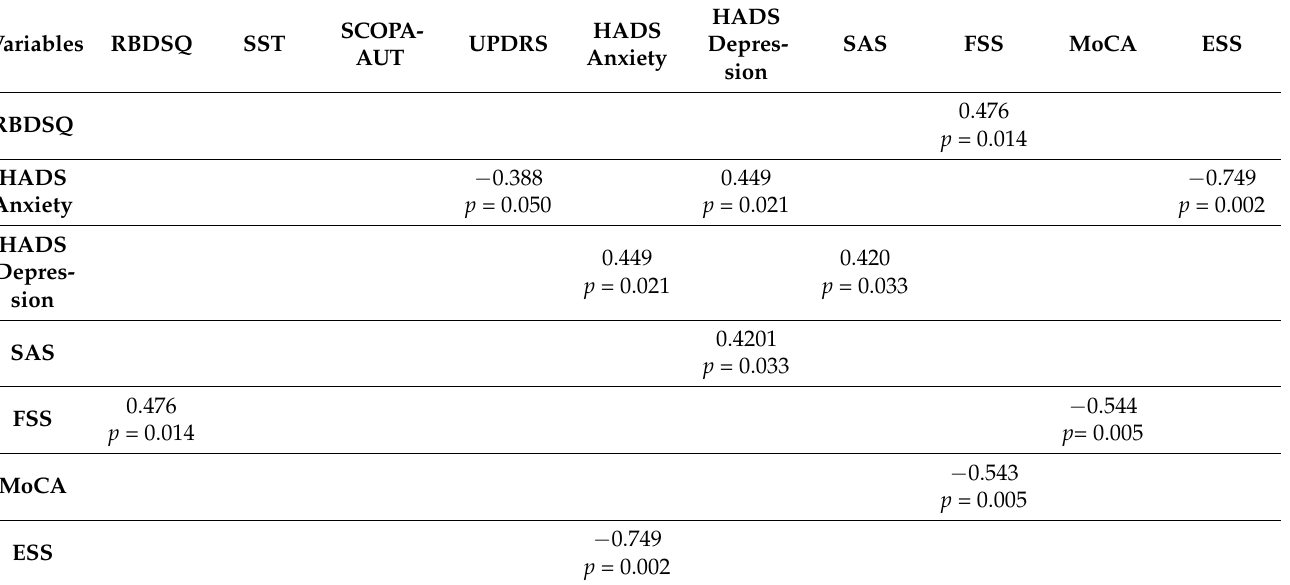
Table 2. Statistically significant correlations between